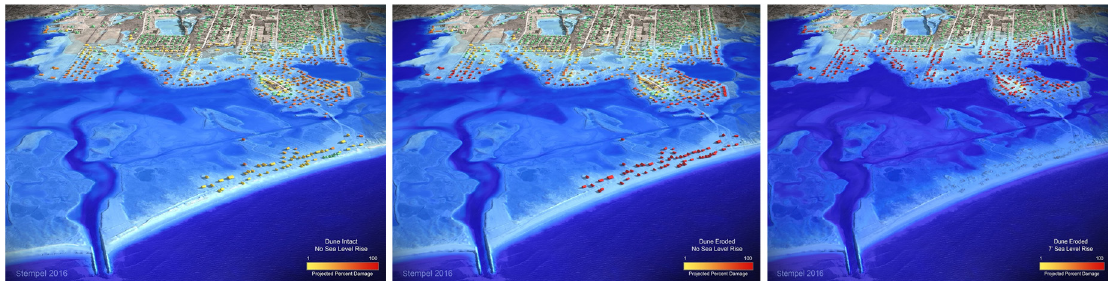
Figure 22. Three dimensional (3d) visualization of the percent damage to structures for Charlestown, RI: 100 year dunes intact (upper panel), 100 year dunes eroded (center panel), and 100 year dunes eroded, with 2.1 m (7 feet) SLR and shoreline erosion (lower panel). The lower panel projects coastal erosion to 2100.